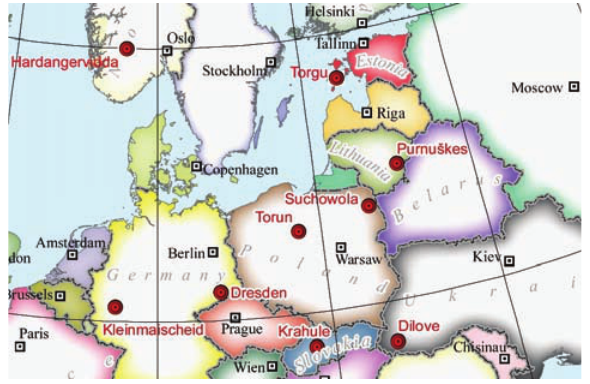
Fig. 3. Various Claims for the European Centre